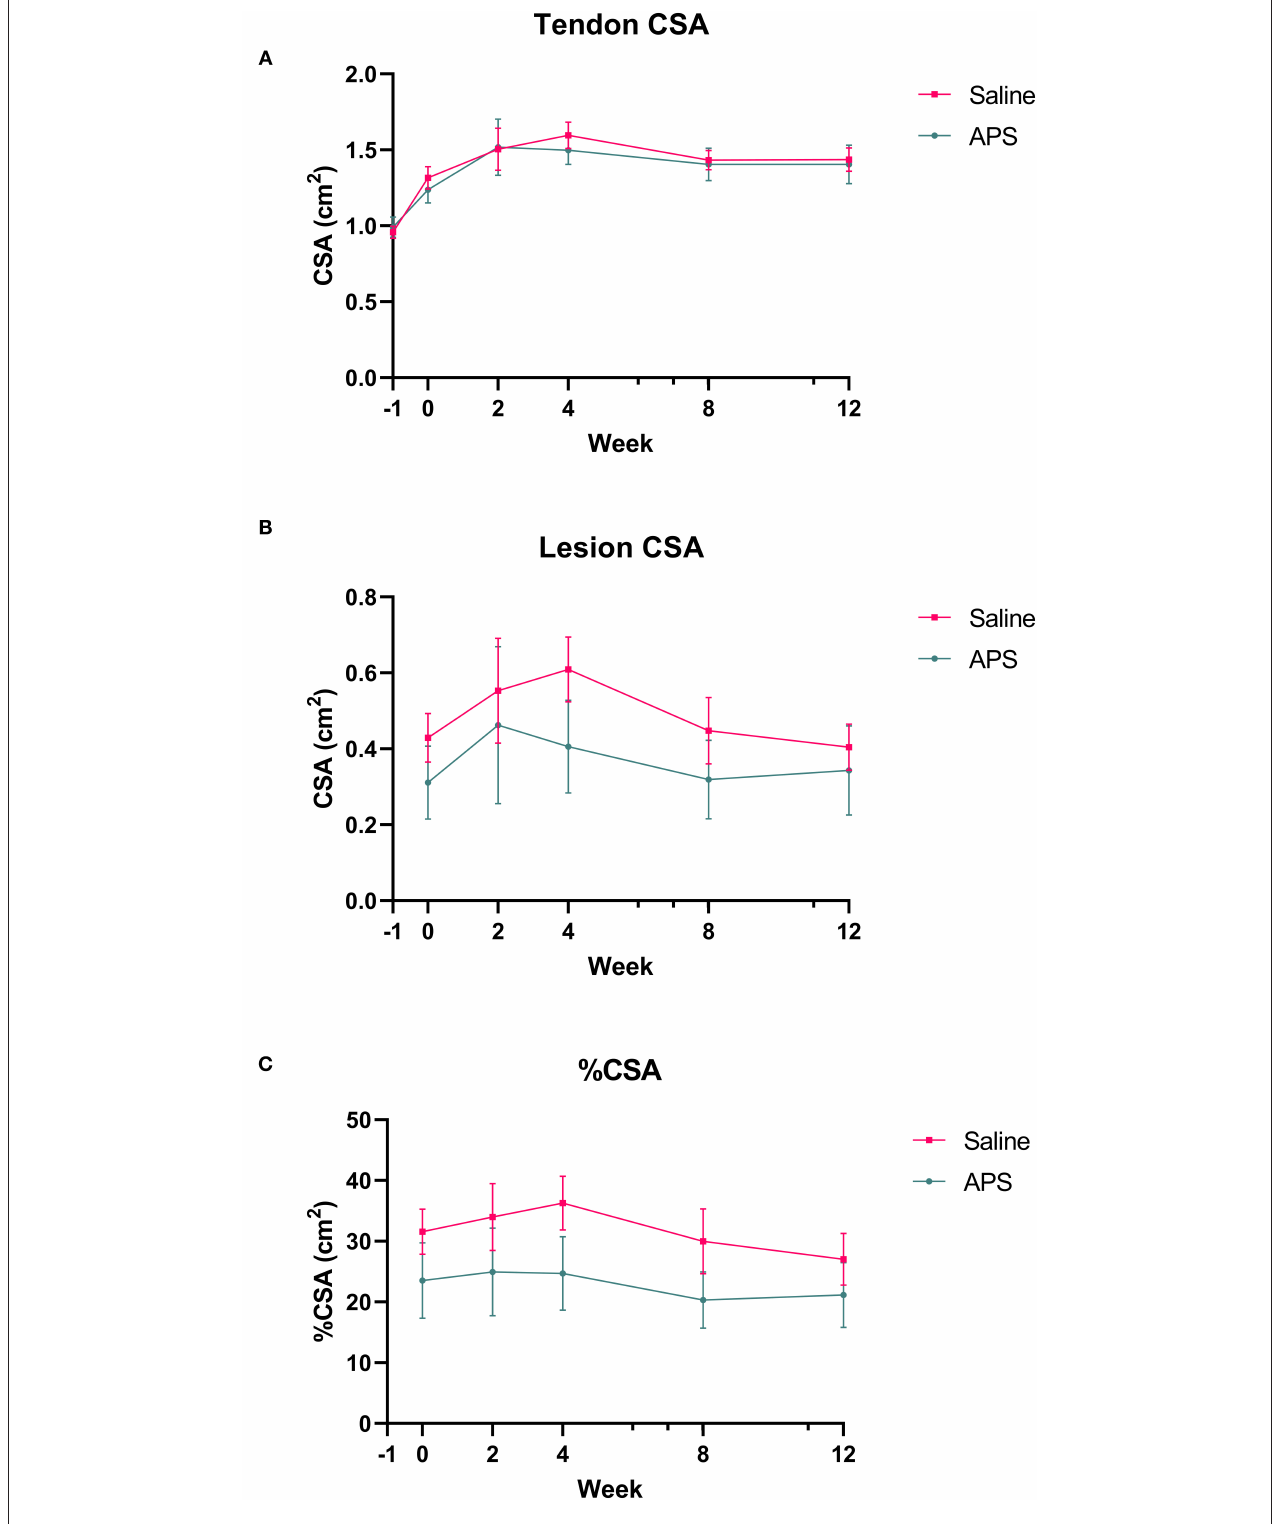
FIGURE 1 | Mean ( ± SEM) cross-sectional area (CSA) of the (A) tendon and (B) lesion at the maximal injury zone (14–18cm DACB) at 0, 2, 4, 8, and 12 weeks following intra-lesional injection of saline or APS. Relative cross sectional area of the lesion (%CSA) occupied by the lesion is shown in (C) ( n = 8).